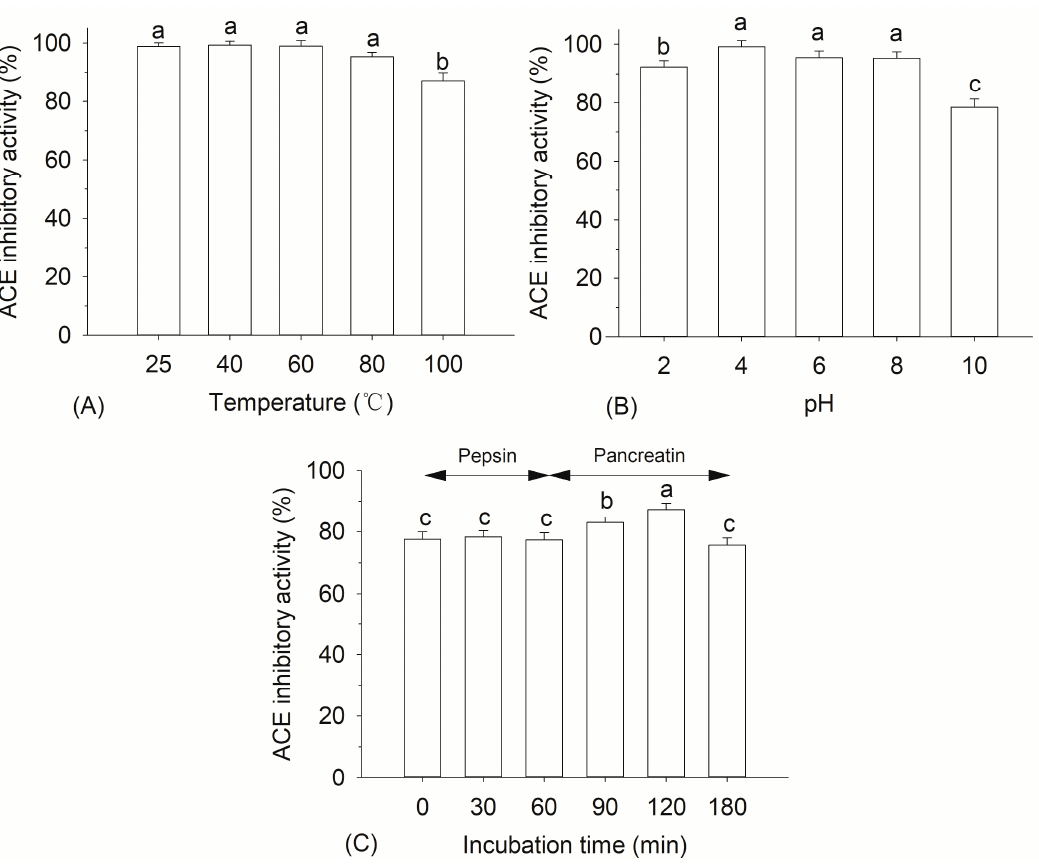
Figure 6. Thermal ( A ), pH ( B ) and digestive ( C ) stabilities of gelatin hydrolysates with the highest DH. Different letters indicate that the results differ signi fi cantly ( p < 0.05).